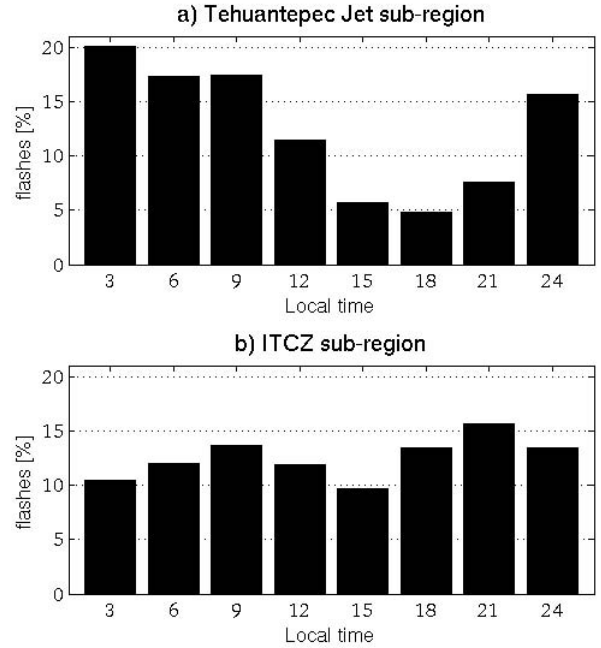
Fig. 7. Diurnal cycles of flashes in the (a) Tehuantepec Jet and (b) ITCZ sub-regions over the Pacific Ocean. The three-hour averages are centered at the indicated